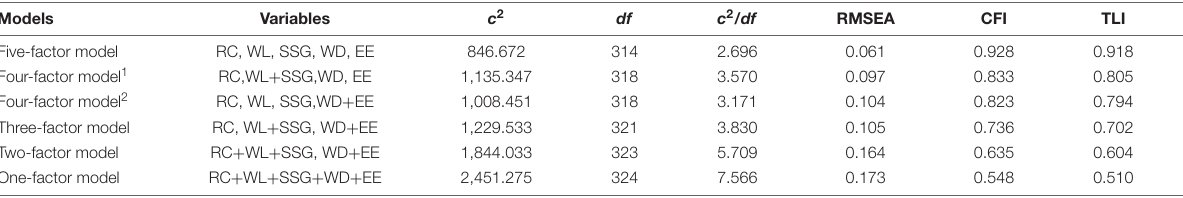
TABLE 1 | Results of confirmatory factor analyses.